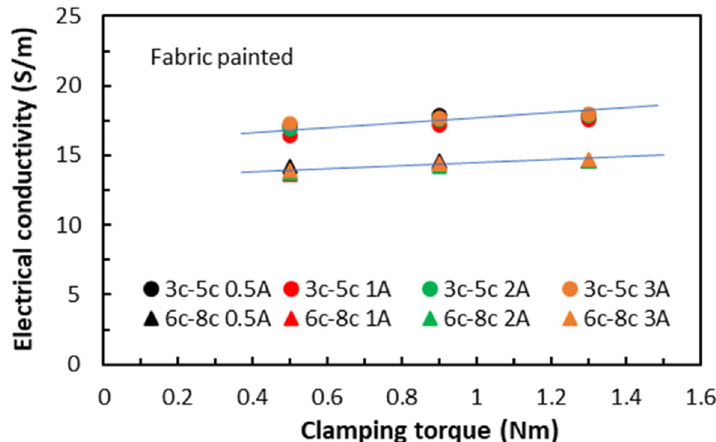
Fig. 19 Effect of clamping torque on TTT electrical conductivity for painted